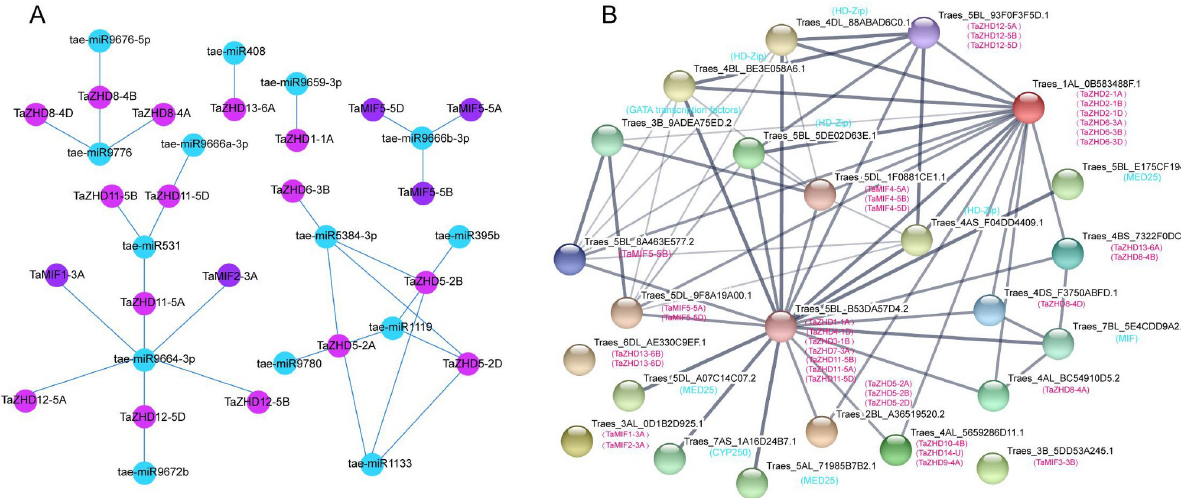
Fig 5. Protein interaction and miRNA targeting analysis. ( A ) The picture of the regulatory network relationships between the putative miRNAs and their targeted wheat ZF-HD genes. Different colored circles represent different types, blue represents miRNA, purple indicates predicted miRNA target genes. ( B ) Interaction networks of the wheat ZF-HD